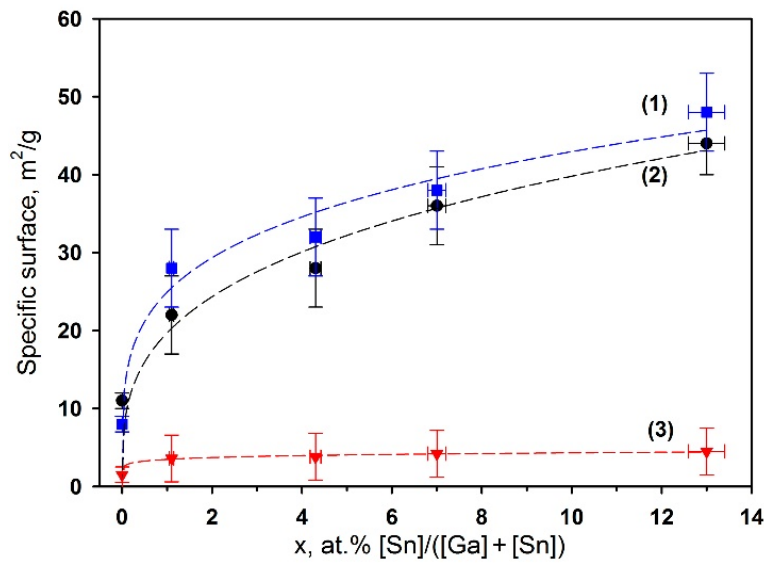
Figure 4. Specific surface of Ga 2 O 3 samples annealed at 500 ( 1 ), 750 ( 2 ) and 1000 °C ( 3 ).